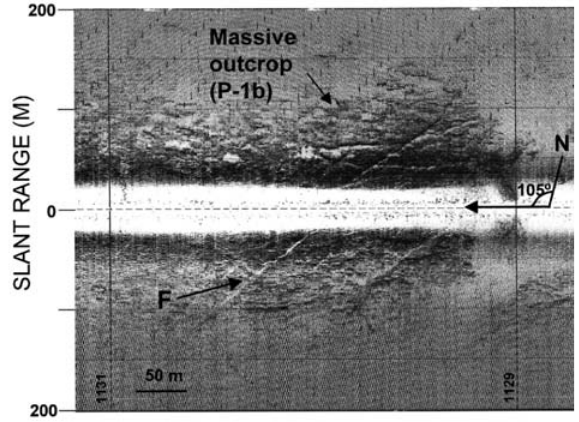
F IG . 8. – Sonograph showing a train of straight bifurcated megarip- ples crests with a wavelength of 3.33 m developed on coarse grained sediments, and located between granite outcrops at the north entrance of the Ría. See Fig.4 for